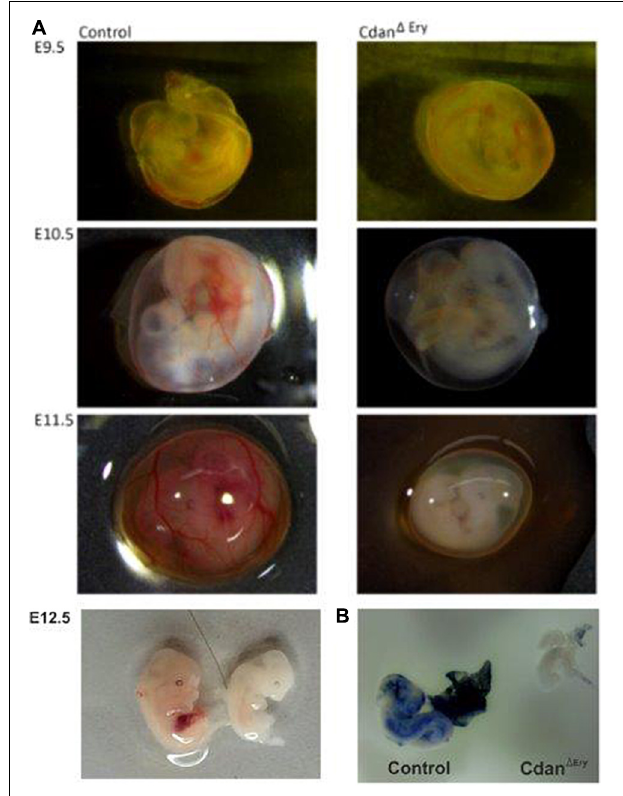
FIGURE 1 | Cdan (cid:49) Ery embryos die in-utero between E12.5 and E13.5 from severe anemia. (A) Cdan (cid:49) Ery embryos were extracted and photographed at different dpc. From E10.5 and on, Cdan (cid:49) Ery embryos and Yolk Sacs (right column) are very pale with no visible vasculature or Fetal Liver. (B) Benzidine staining of E10.5 Cdan (cid:49) Ery embryo (right) Vs. littermate control (left). Mutant embryo and Yolk sac stained very lightly and are notably